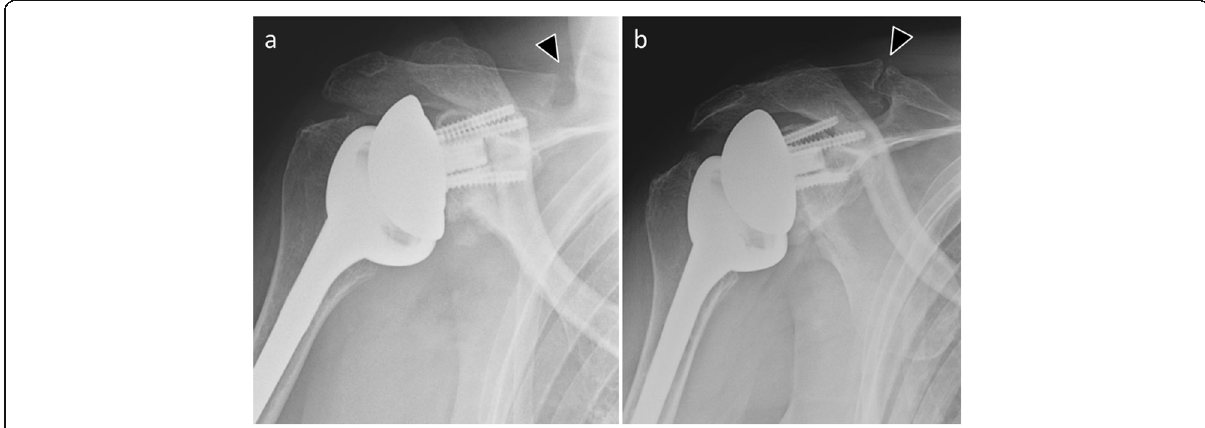
Fig. 14 Anteroposterior radiographs of a 67-year-old woman with reverse shoulder arthroplasty. a Radiograph shows a proximal scapular spine fracture (arrowhead). b This fracture is more visible after a few weeks due to pseudoarthrosis